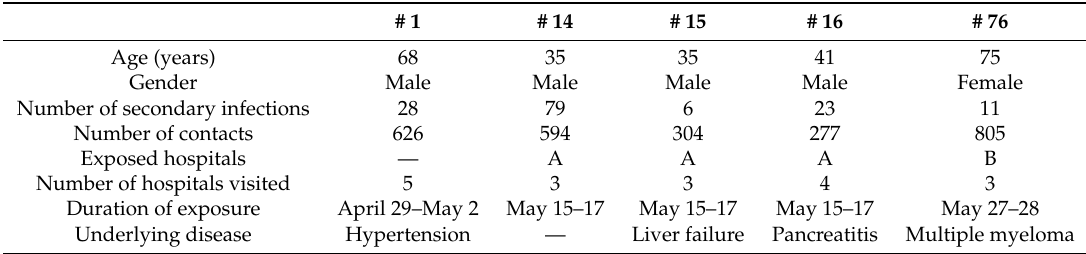
Table 1. Characteristics of the five